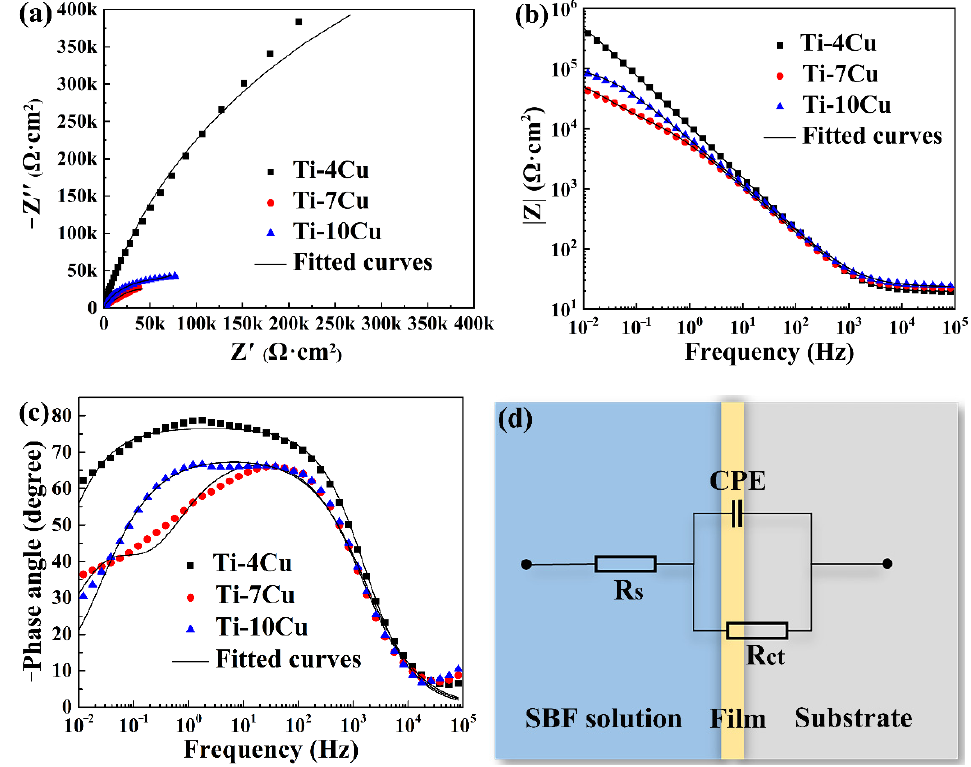
Figure 11. Electrochemical impedance spectrum (EIS) plots of the as-cast Ti-xCu alloys: ( a ) Nyquist plots, ( b ) Bode plots, ( c ) Bode phase angle plots, ( d ) equivalent circuits used for fitting the EIS. Table 6. Electrochemical parameters of the fitting equivalent